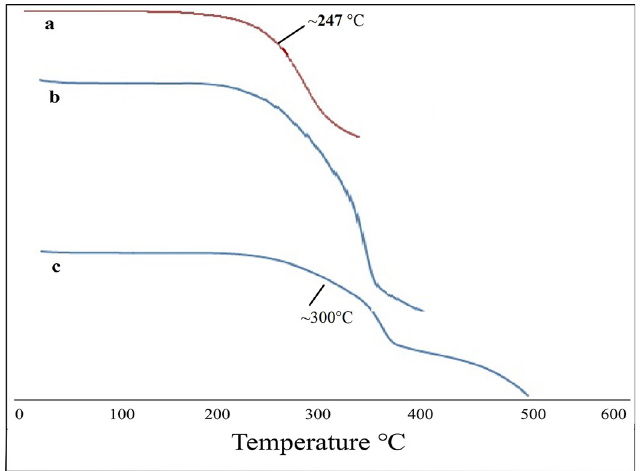
Fig 7. Thermogravimetric analysis of Pentazocine (a), Physical mixture (b), and optimized microsphere formulation